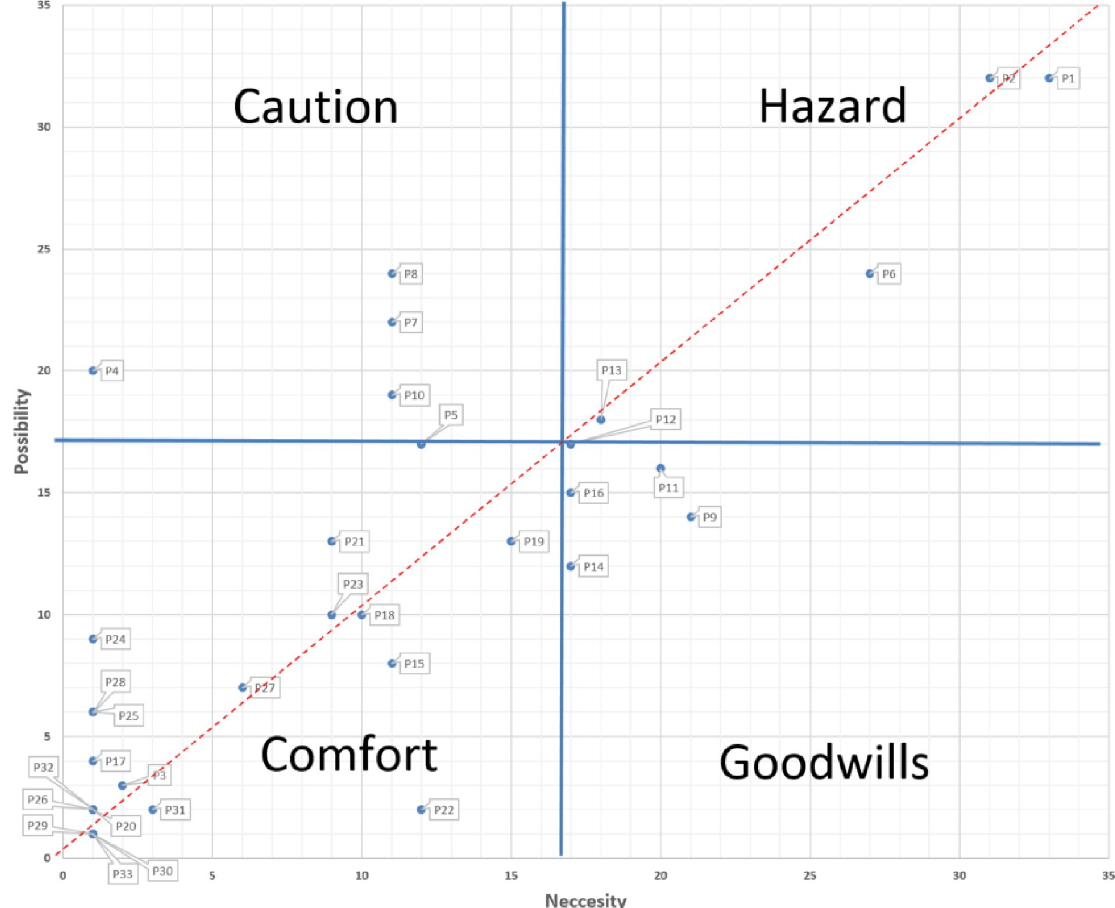
Fig 3. Project performance strategy map with two feasibility